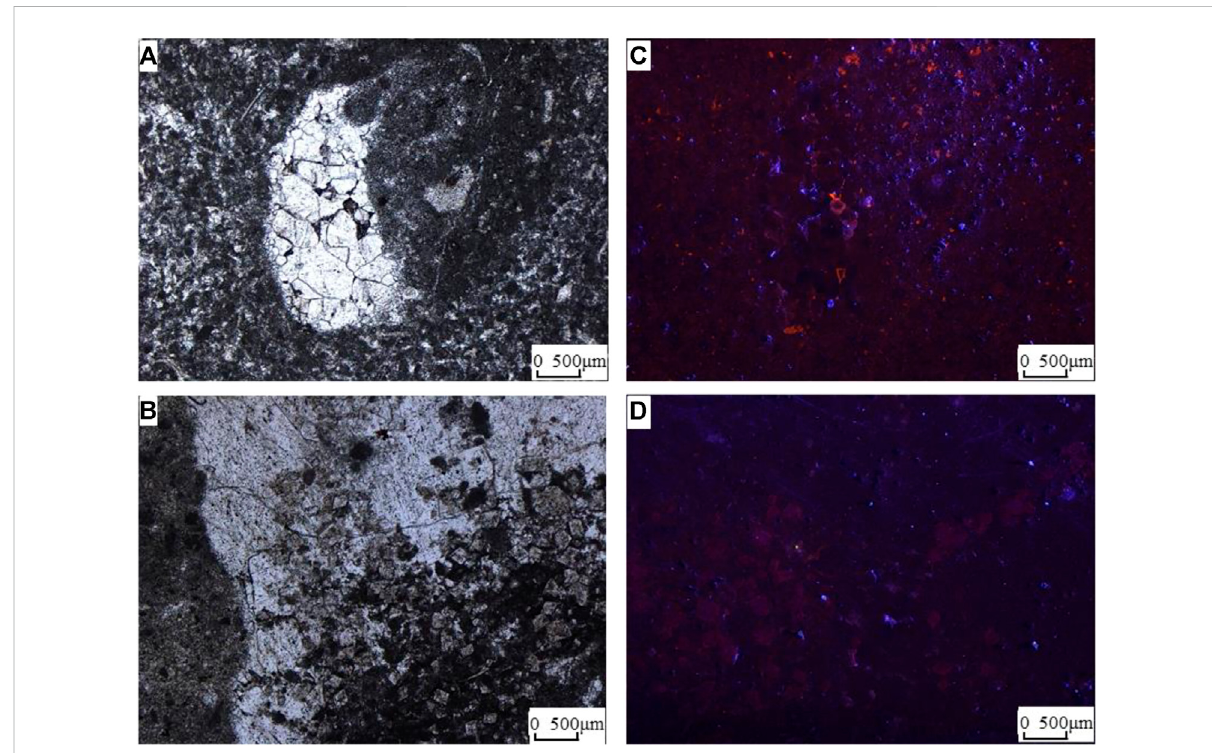
FIGURE 7 FillingsinOrdoviciancarbonatekarstcavesofShuntuoguolearea. (A) Bottomstructureofatmosphericwater karst;thebottomofthedissolved cave (upper corner on the right) is fi lled with dissolved residual, and the top of the dissolved pore (lower corner on the left of the pore) was fi lled by calcite,Shunbeiarea,O2yj. (B) Bottom structureforkarstofatmosphericwater;thedissolution residualis fi lledindolomiteparticlesatthebottomof dissolutionpore(lowercornerontheright),andcalciteis fi lledatthetopofthedissolutionpore,Shunbeiarea,O1y. (C) Filledcalciteatthetopof the dissolved pore is not luminous, and the residue at the bottom is bright blue, as a clay debris residue, Shunbei area, O2yj. (D) Bottom structure for atmospheric karst; dissolved residuals are fi lled in dolomite particles at the bottom of dissolved pores (lower corner on the right) without luminosity, and calcite is fi lled in dissolved pores in at the top without luminosity, Shunbei area,